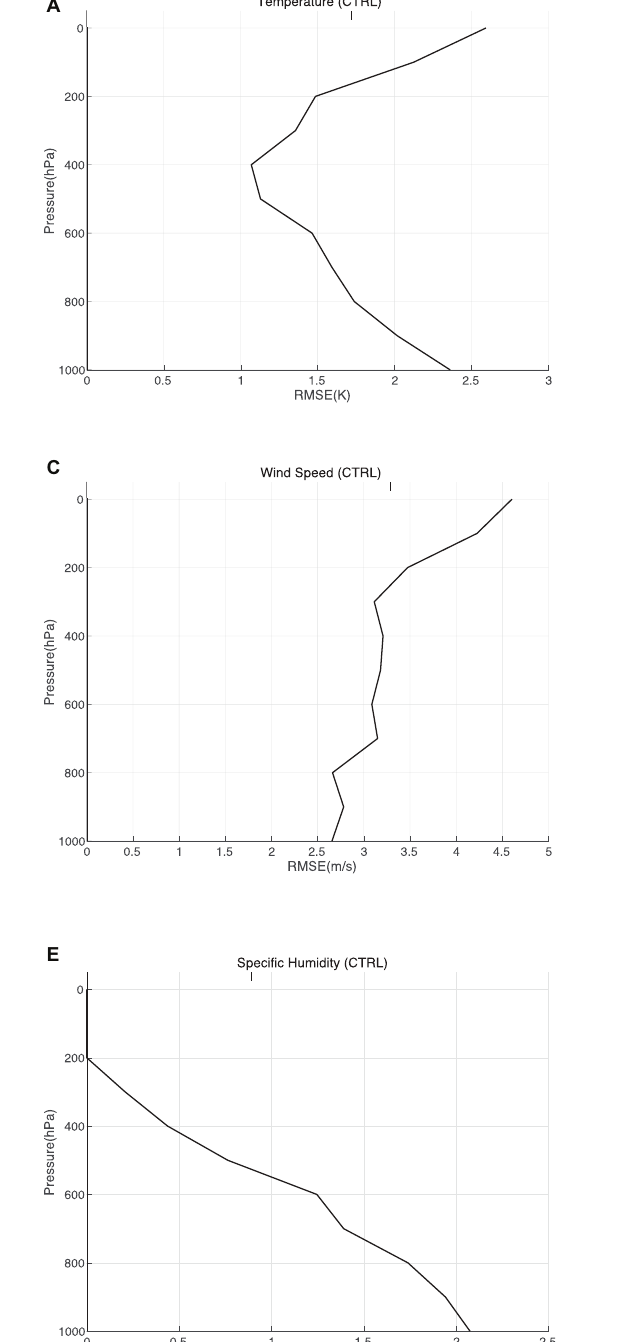
decreasing with height since water vapor decreases with height ( Figure 6E ). GGF experiments generally have smaller errors of specific humidity than CTRL, especially between 900